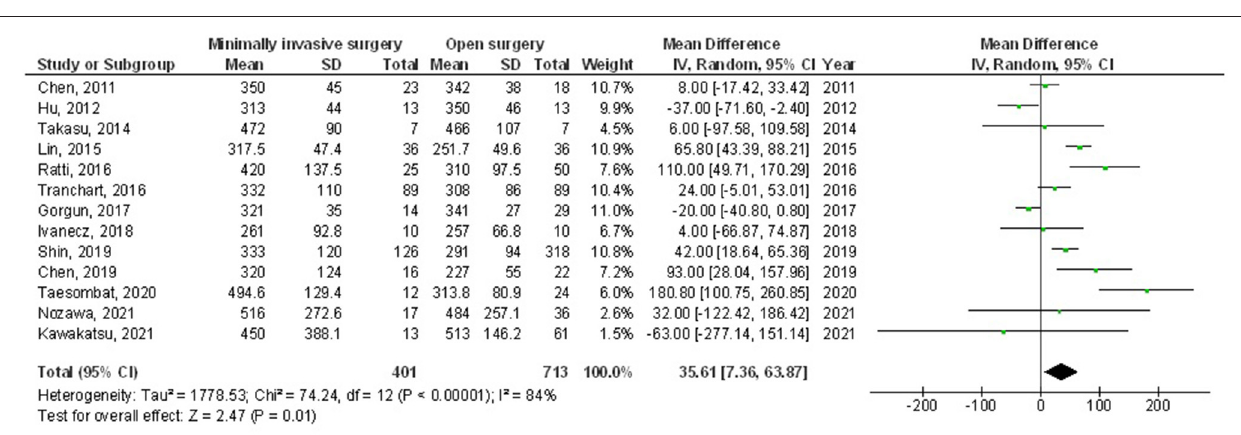
FIGURE 8 | Forest plot of the effect of minimally invasive surgery compared to open surgery on disease-free survival in subjects with colorectal cancer and synchronous colorectal liver metastases.